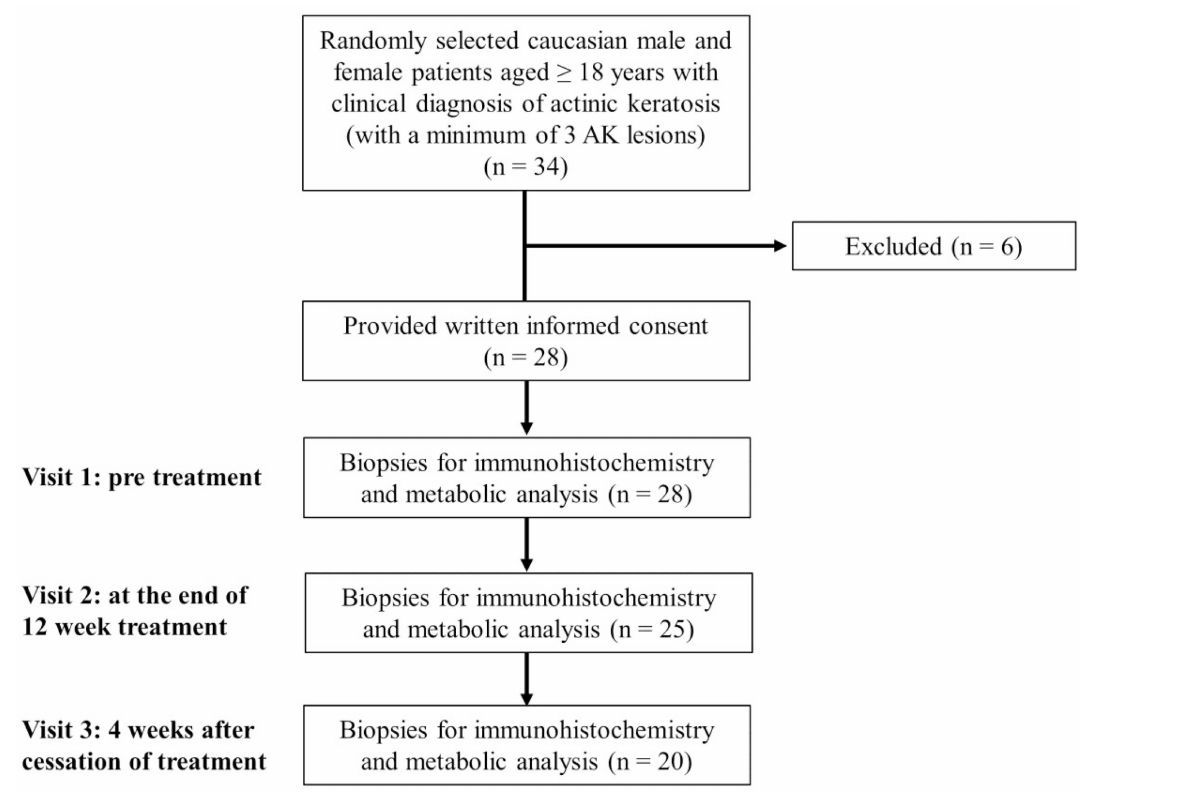
TABLE 1 | Flow diagram of the